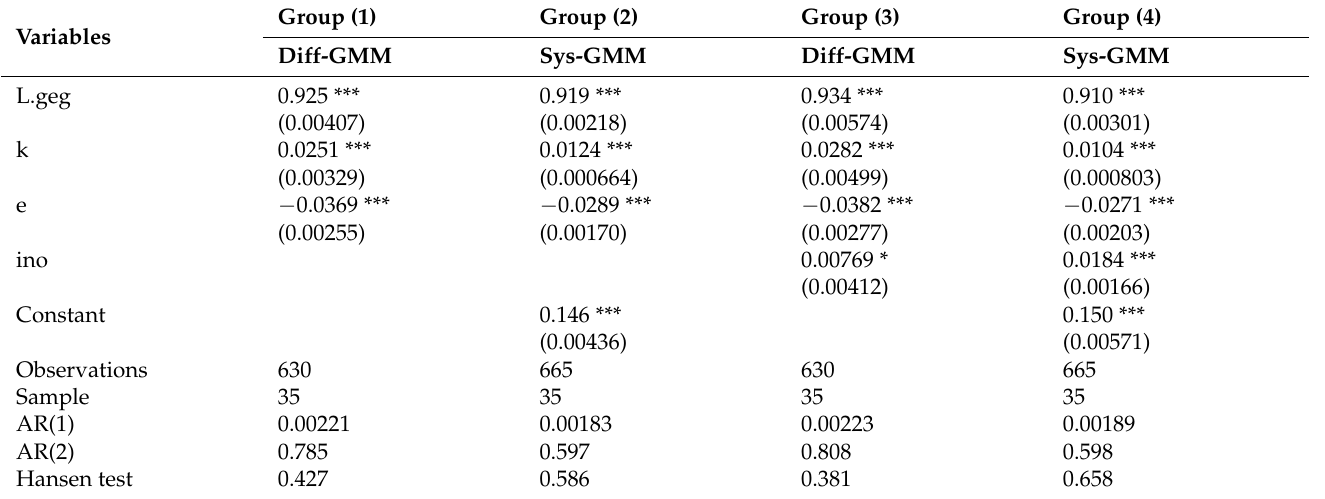
Table 4. The production function (OECD).